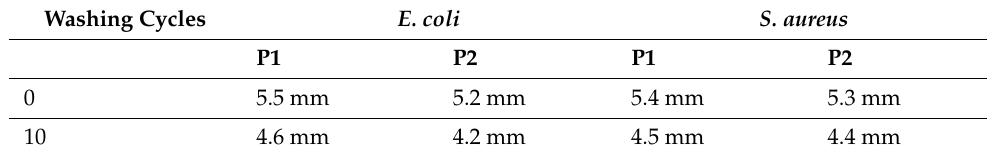
Table 2. Inhibition zones of samples P1 and P2 against E. coli and S. aureus bacteria . Washing Cycles